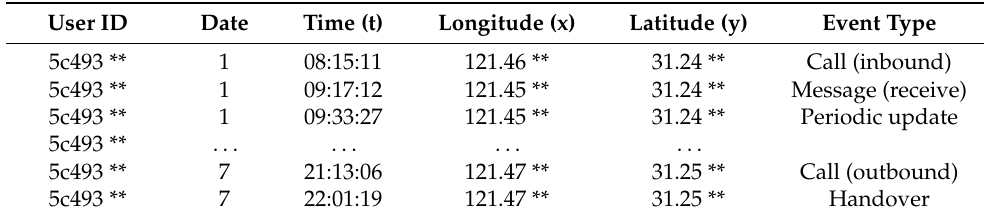
Table 1. Example of mobile phone data.